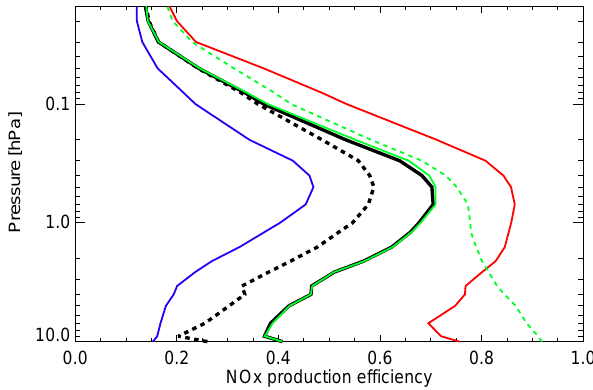
Fig. 13. NO x production efficiency (ratio of the net NO x increase and the integrated initial N production) during the period of the main proton forcing (28 October–1 November) from box model cal- culations for night- and daytime conditions (solid and dashed black lines, respectively), assuming initial atmospheric conditions as ob- served by MIPAS in the polar cusp region. The following variations for dark conditions are also shown: a 20K temperature increase (red) and decrease (blue), a factor of 2 increase of O 3 (solid green), and initial NO x abundances set to zero (dashed green).